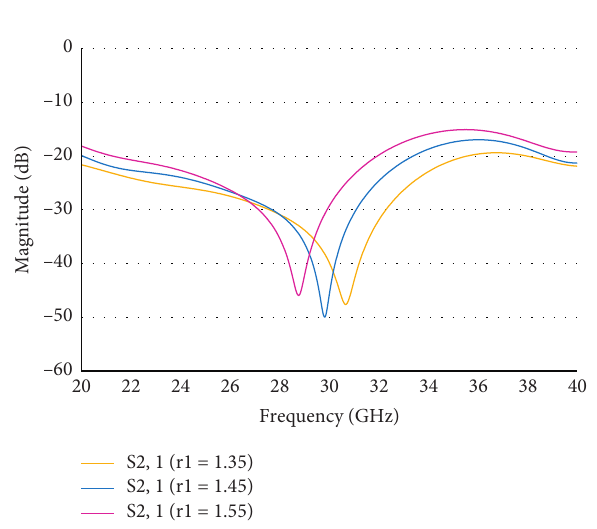
Figure 4: Effect of the “ R